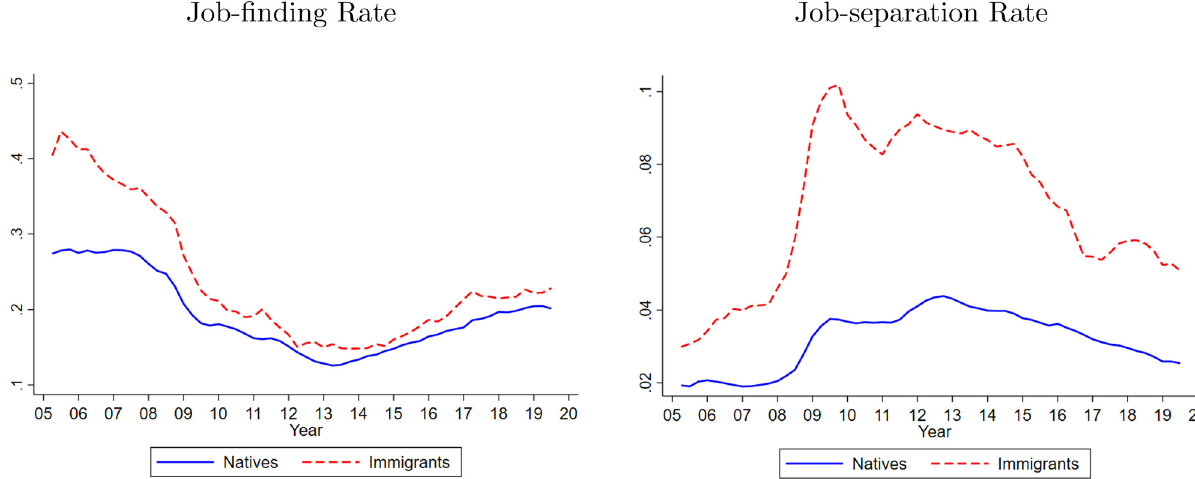
Figure 4: Labour market transitions by nationality. Note: The transitions are seasonally adjusted using a 4 - quarters moving average, constructed from the Spanish Labour Force Survey -